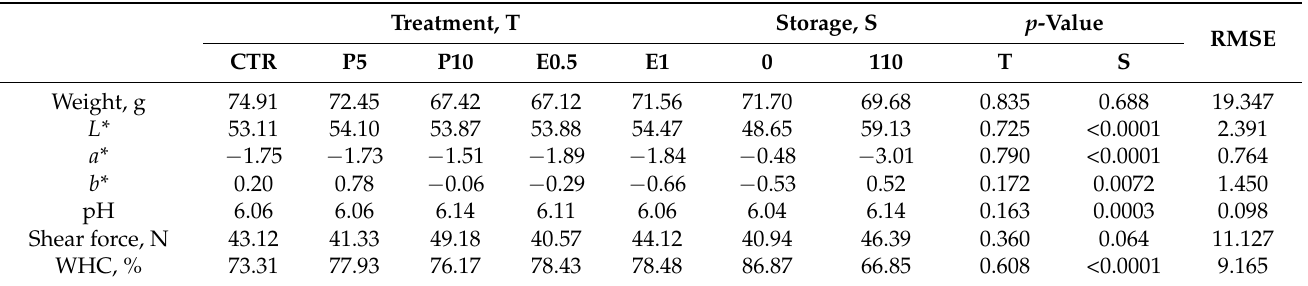
Table 3. Physical characteristics of fillets from gilthead seabream fed the different dietary treatments analyzed before (day 0) and after 110 days of frozen